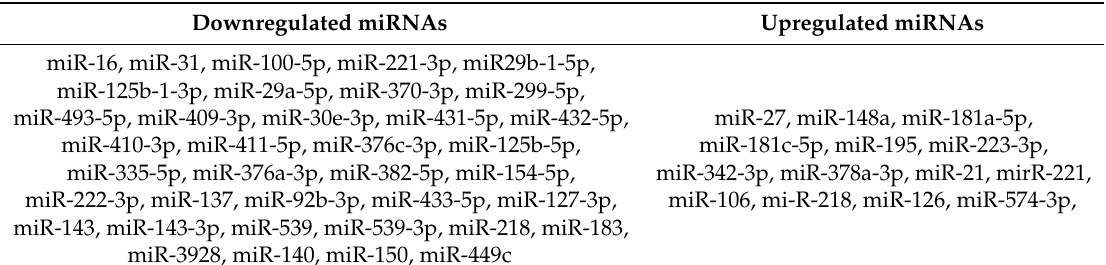
Table 4. Downregulated and upregulated miRNA in osteosarcoma (OS) patients [74,101,102,108,109]. Downregulated miRNAs Upregulated